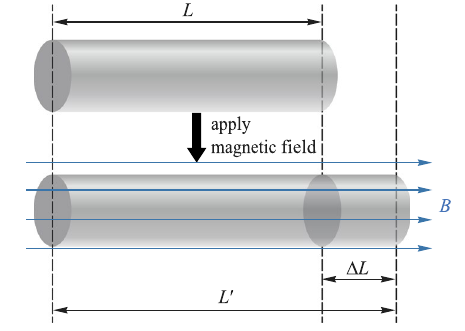
Fig. 14 Principle of magneto-strictive effect